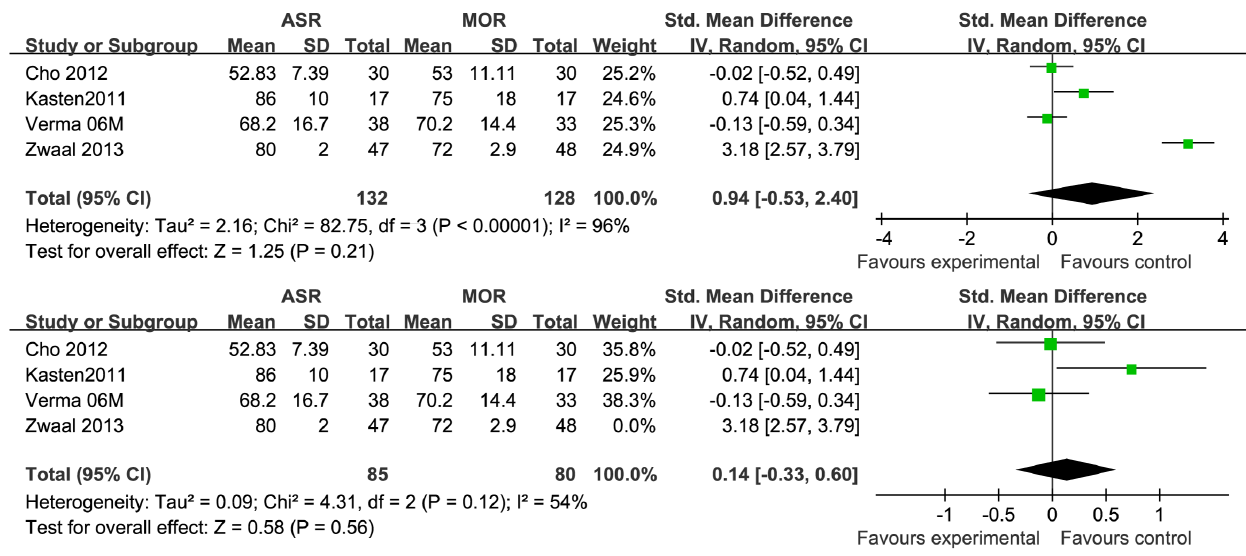
Figure 3. Forest plot showing the SMD (Standardized mean difference) and 95% CI for External rotation after surgery with and without the study by Zwaal 13 during a sensitivity analysis. The heterogeneity decreased significantly when the study by Zwaal et al was excluded.